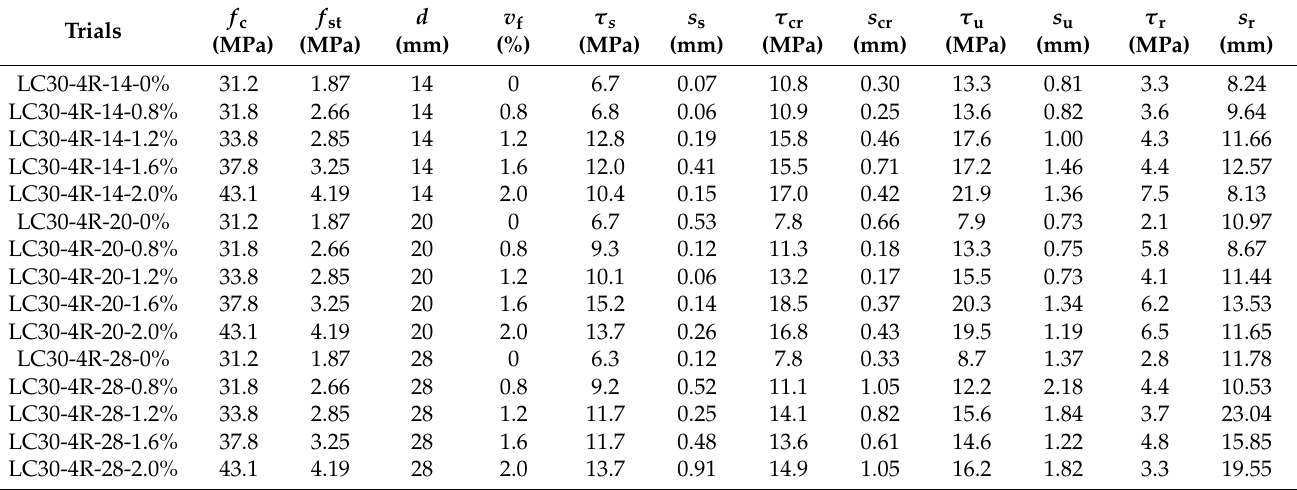
Table 7. Test results of bond strength and peak